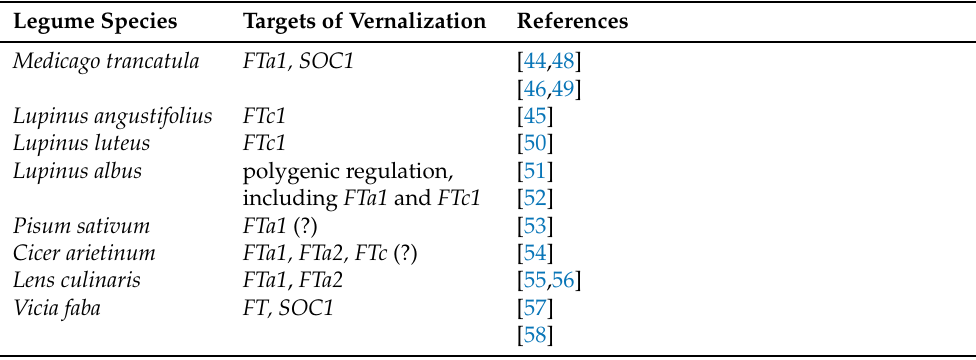
Table 2. Major vernalization targets ( FT and SOC1 genes) in different legume species. Legume